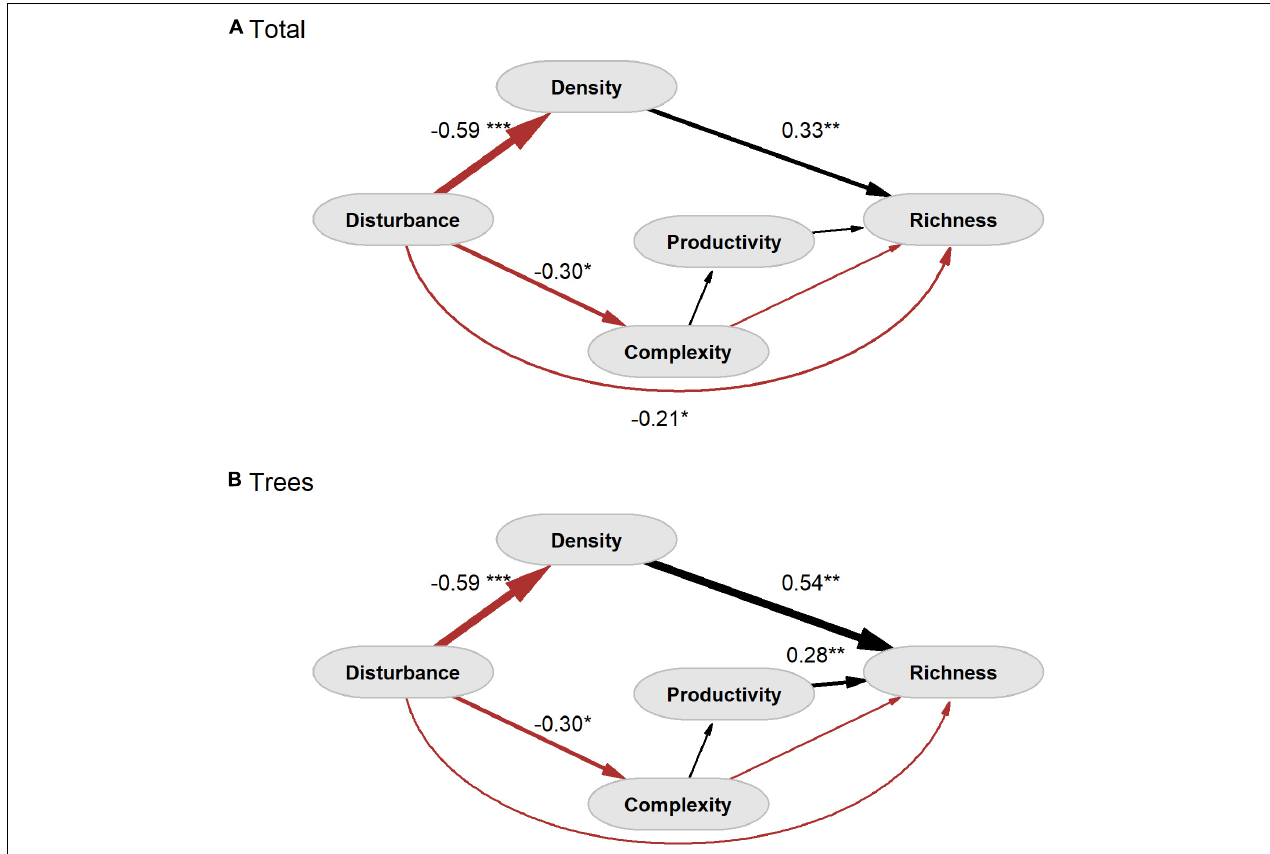
FIGURE 3 | Results of structural equation models (SEMs) after correction by not normality of the model. (A) Total woody species richness and (B) tree species richness. Number associated with paths between variables represents path coefficients. Path coefficients presented are values standardized by the standard deviations of the variables. The thickness of the arrow is indicative of the standardized coefficient value. Red arrows represent negative effect and black arrows represent positive effect. P -value is showed to the significant pathways * p < 0.05, ** p < 0.01 and *** p < 0.001.